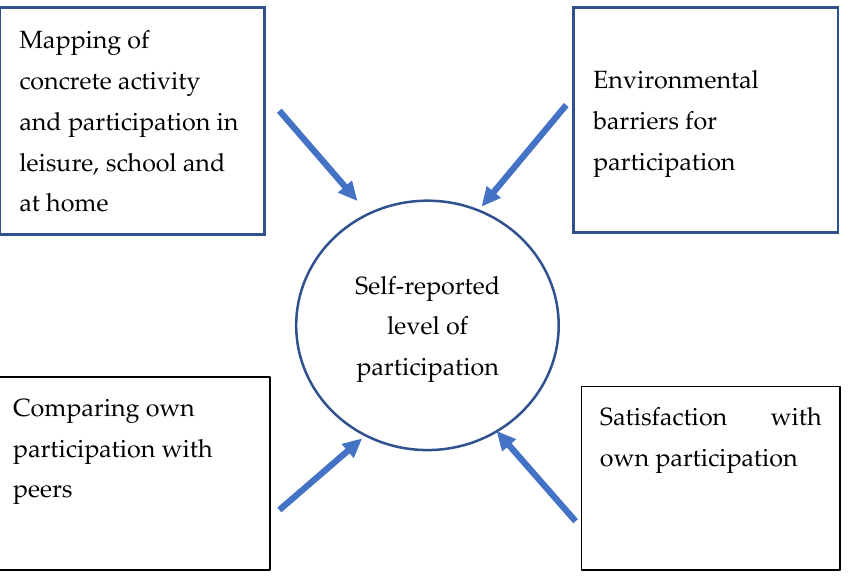
Figure 2. Participation indicators in the questionnaire.